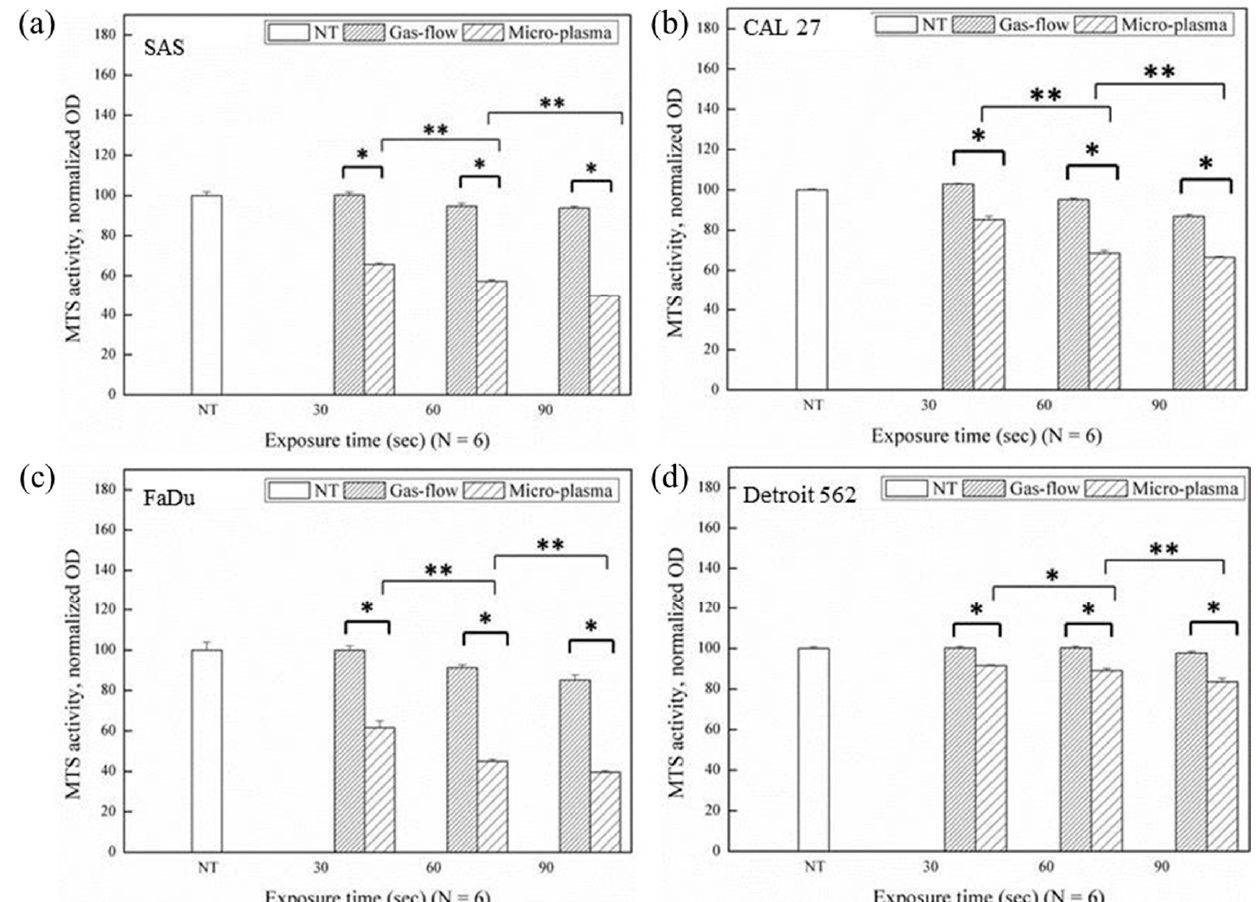
Figure 3. Cells viability (or proliferation) of ( a ) SAS, ( b ) CAL 27, ( c ) FaDu, and ( d ) Detroit 562 in the stimulated medium after plasma exposure and gas flow for a similar duration and then cultured for 48 h. The medium without cells and the medium with cells and gas flow for a similar duration were taken as the references. The values of p < 0.05 (*) and p < 0.01 (**) were considered statistically significant.